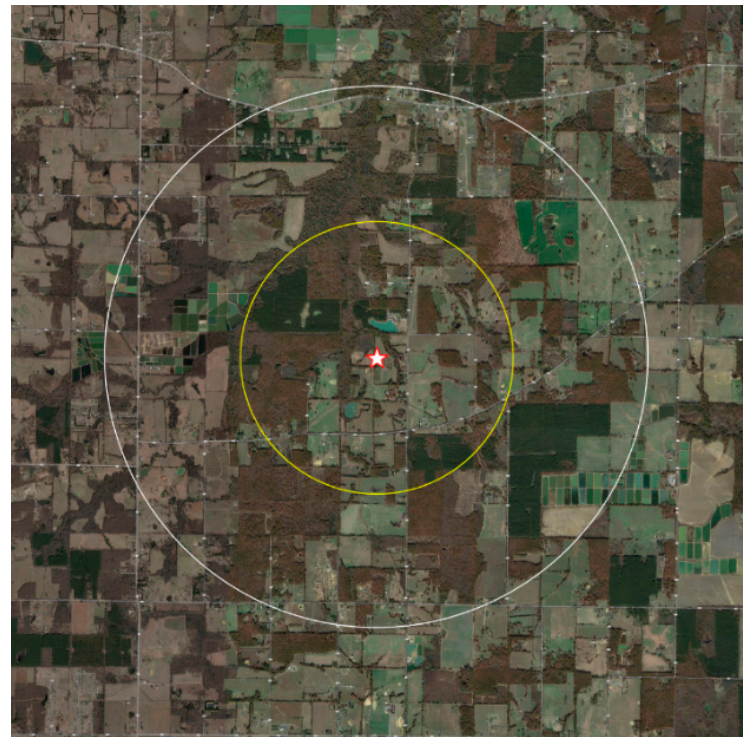
Figure 3. Aerial view of the Low-Ag study site, Lonoke County, Arkansas. The star indicates the apiary location. The yellow circle indicates a one-mile radius from the beehives; the white circle indicates a two-mile radius from the hives. The landscape included a diverse mixture of pasture, woodlands, commercial fish farming, residential gardens, and a few small fruit or orchard operations, but no significant row crop agriculture near the apiary site (data: Google, Maxar Technologies, State of Arkansas, USDA Farm Services Agency). Table 1. Summary of land use within the High-Ag survey site in 2014–2015. This site included all the agricultural fields within approximately two miles of the apiary location. Areas of crop fields that extended outside of a two-mile radius were included in the